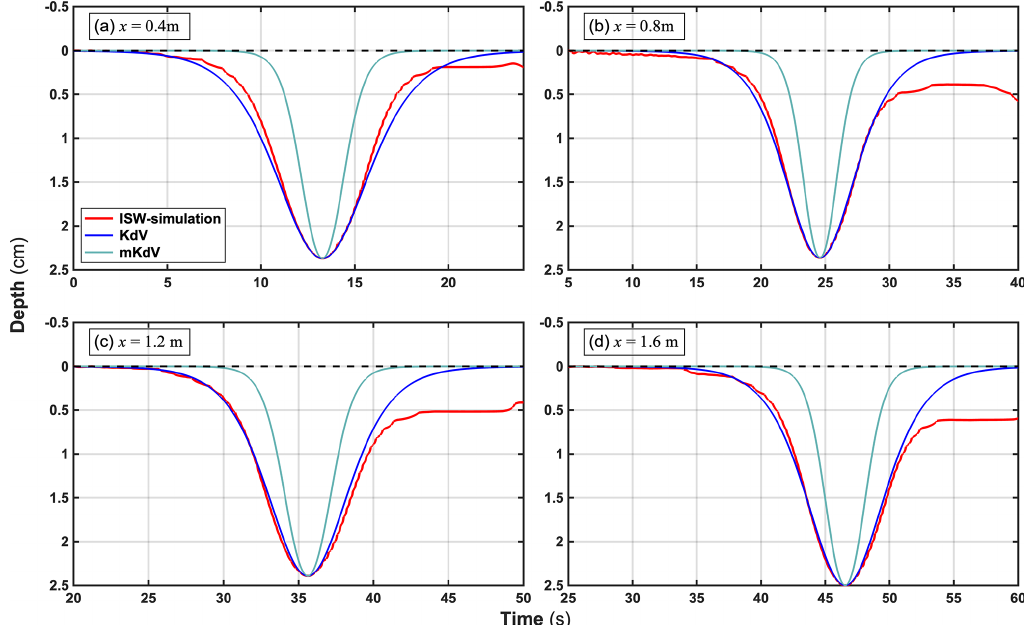
Figure 7. The interface displacement induced by heading ISW at four high-frequency output locations. The red lines indicate the 1026kgm − 3 isopycnic, and the blue and cyan lines represent the KdV and m-KdV model